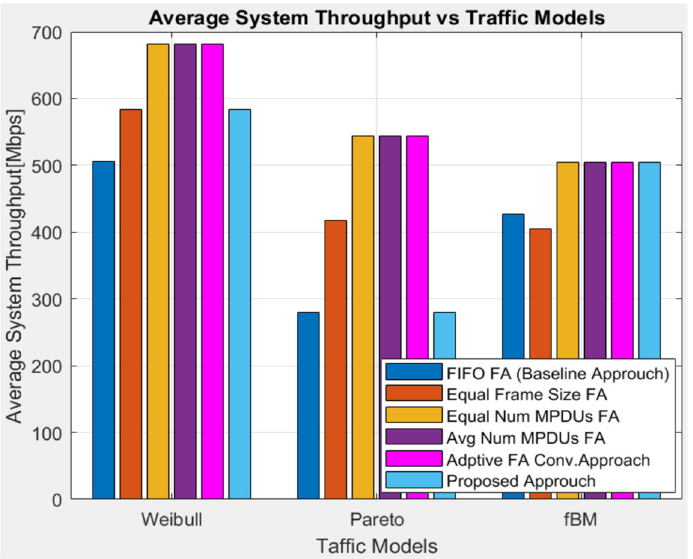
Figure 3. Performance of average system throughput under the effects of heterogenous traffic models when SNR = 8 dB.